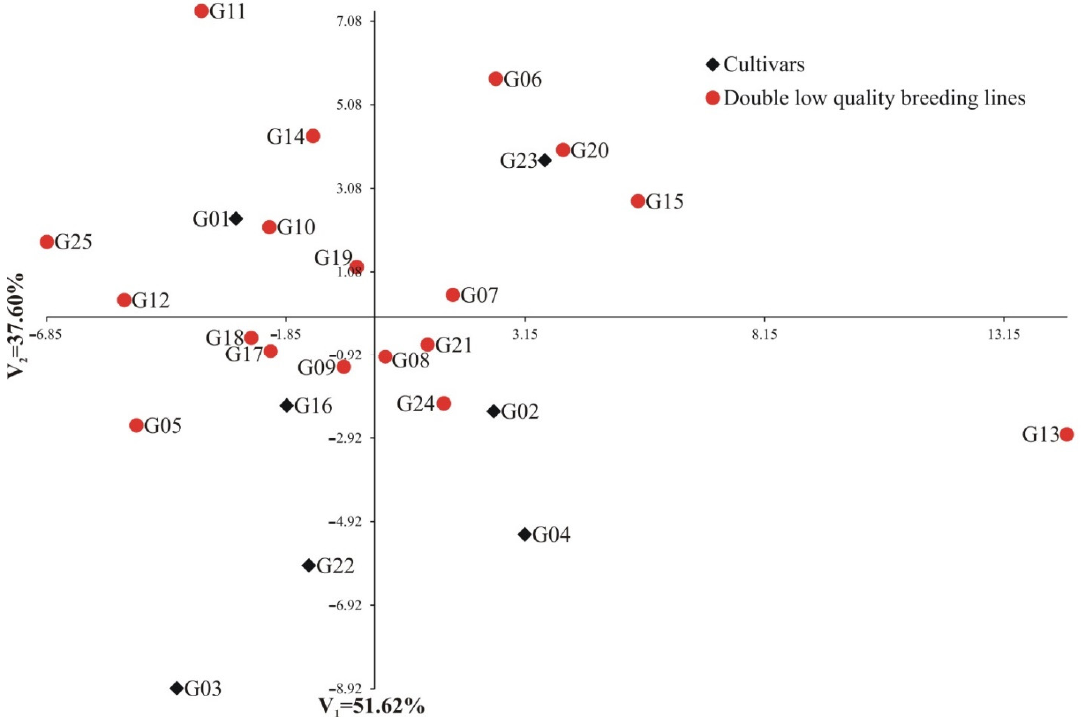
Figure 5. Distribution of 25 genotypes of winter oilseed rape ( Brassica napus L.) in the space of the first two canonical variates in Borowo 2017.